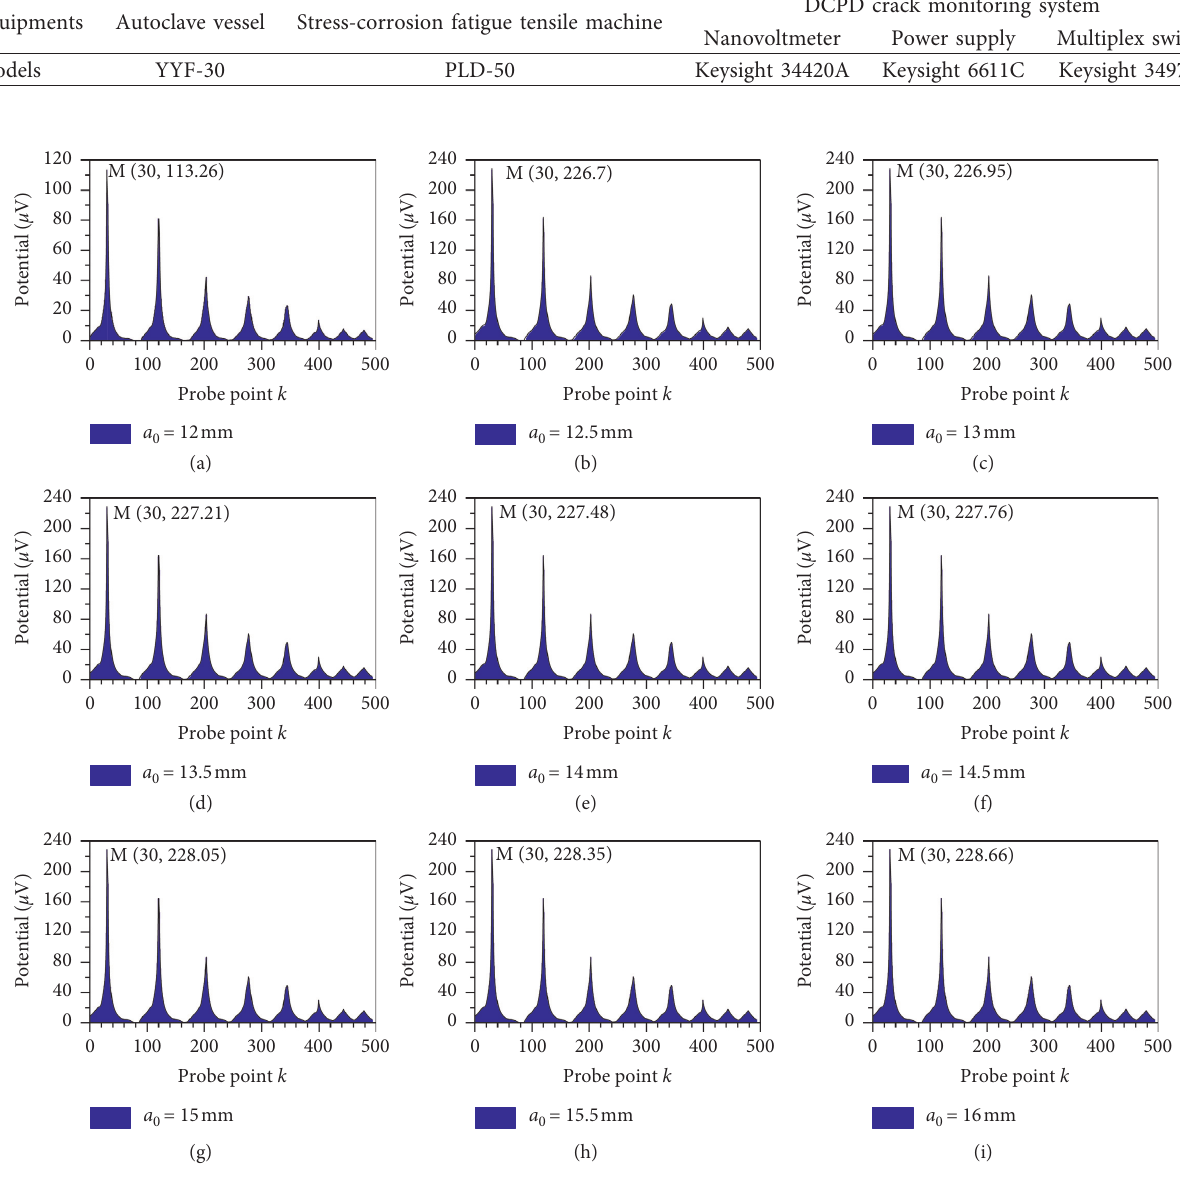
Figure 10: The distribution of the reference potential of the CT